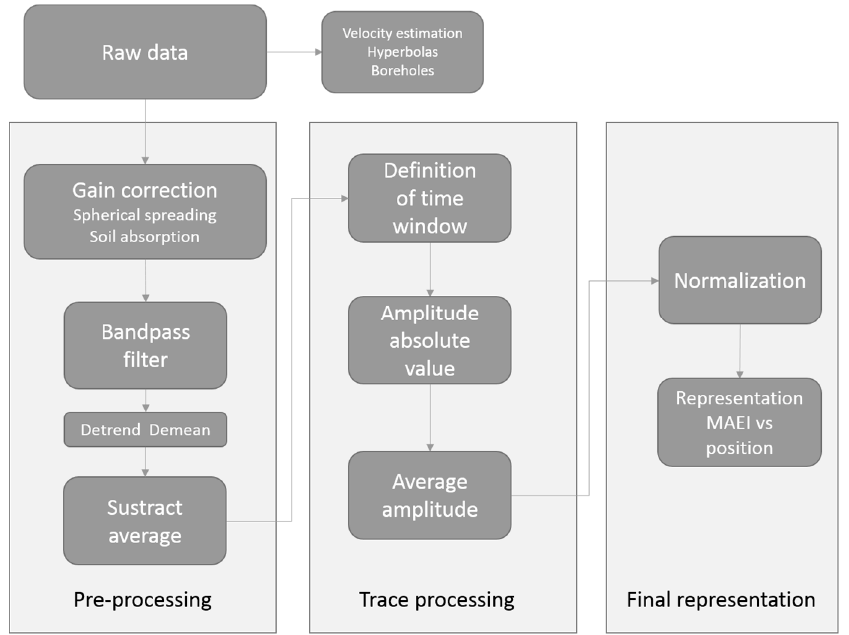
Figure 2. Processing flow diagram.